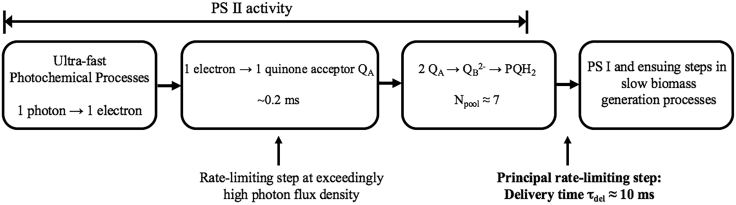
Schematic of the Rate-Limiting Step in Algal Bioproductivity as Implemented in Our Model